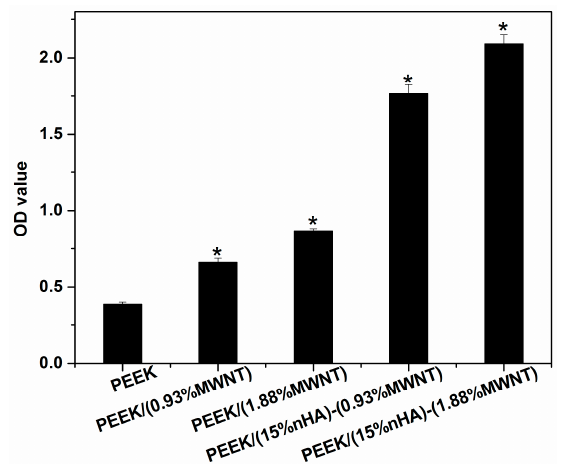
Figure 17. Optical absorbance of MC3T3-E1 pre-osteoblasts cultured on PEEK and its nanocomposites for 28 days and stained with Alizarin red. * represents p < 0.05.